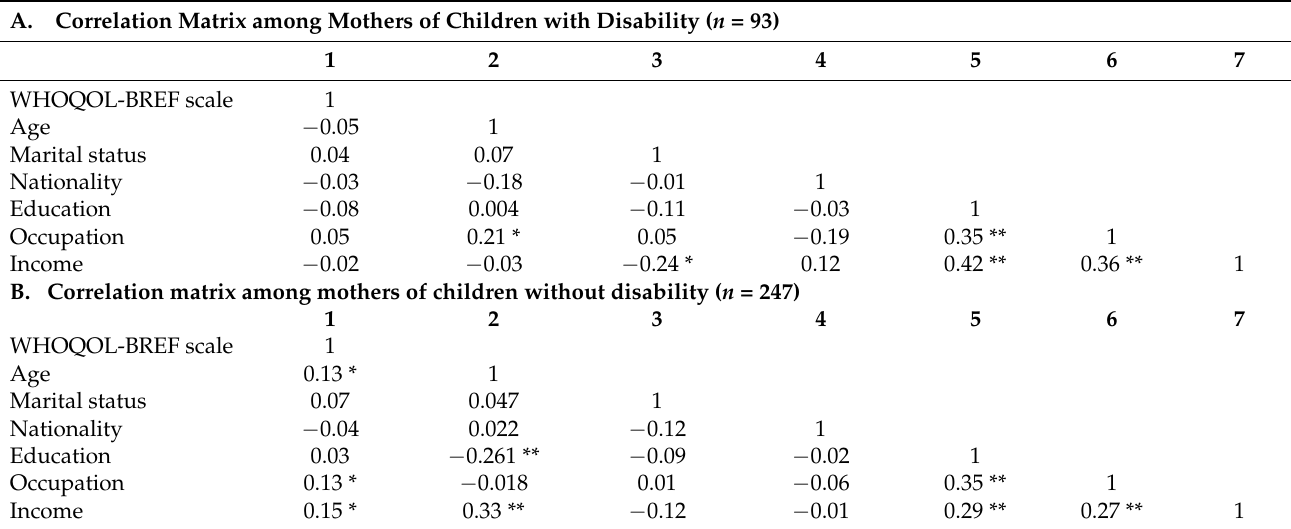
Table 5. Spearman correlation between quality of life and sociodemographic characteristics during the COVID- 19 lockdown. A. Correlation Matrix among Mothers of Children with Disability ( n =